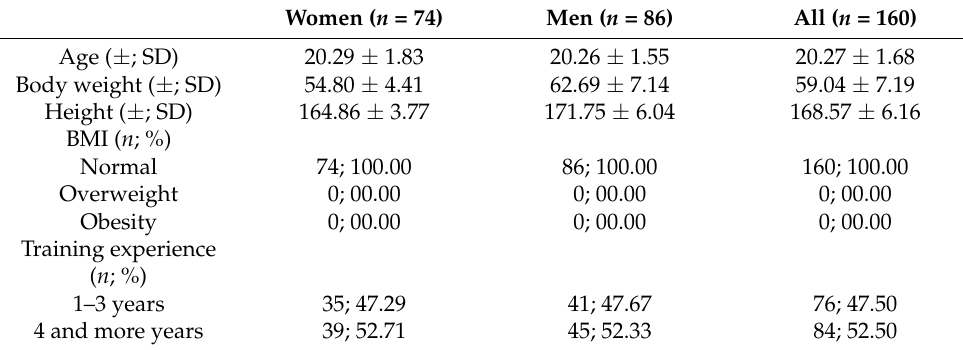
Table 1. Characteristics of the study